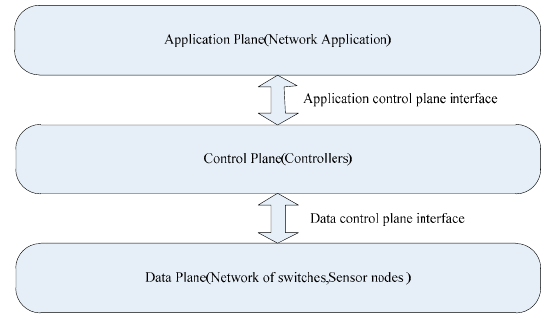
Figure 1. Software defined network (SDN) overall architecture.